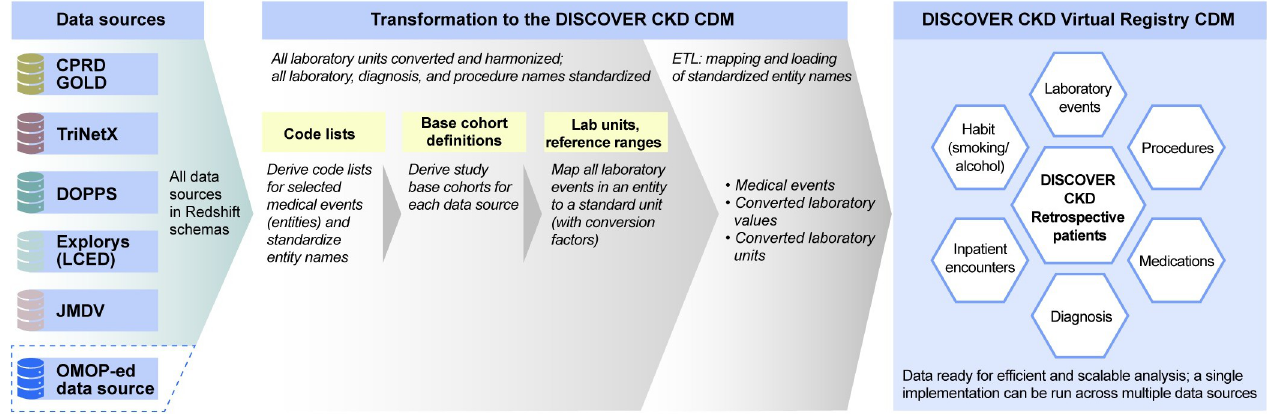
Fig 1. DISCOVER CKD CDM architecture. Blue dashed line denotes potential data sources that could be added to the flexible CDM. CDM, common data model; CKD, chronic kidney disease; CPRD, Clinical Practice Research Datalink; DOPPS, Dialysis Outcomes and Practice Patterns Study; ETL, extract, transform, load; JMDV, Japan Medical Data Vision; LCED, Limited Claims and Electronic Health Record Dataset; OMOP, Observational Outcomes Medical Partnership.